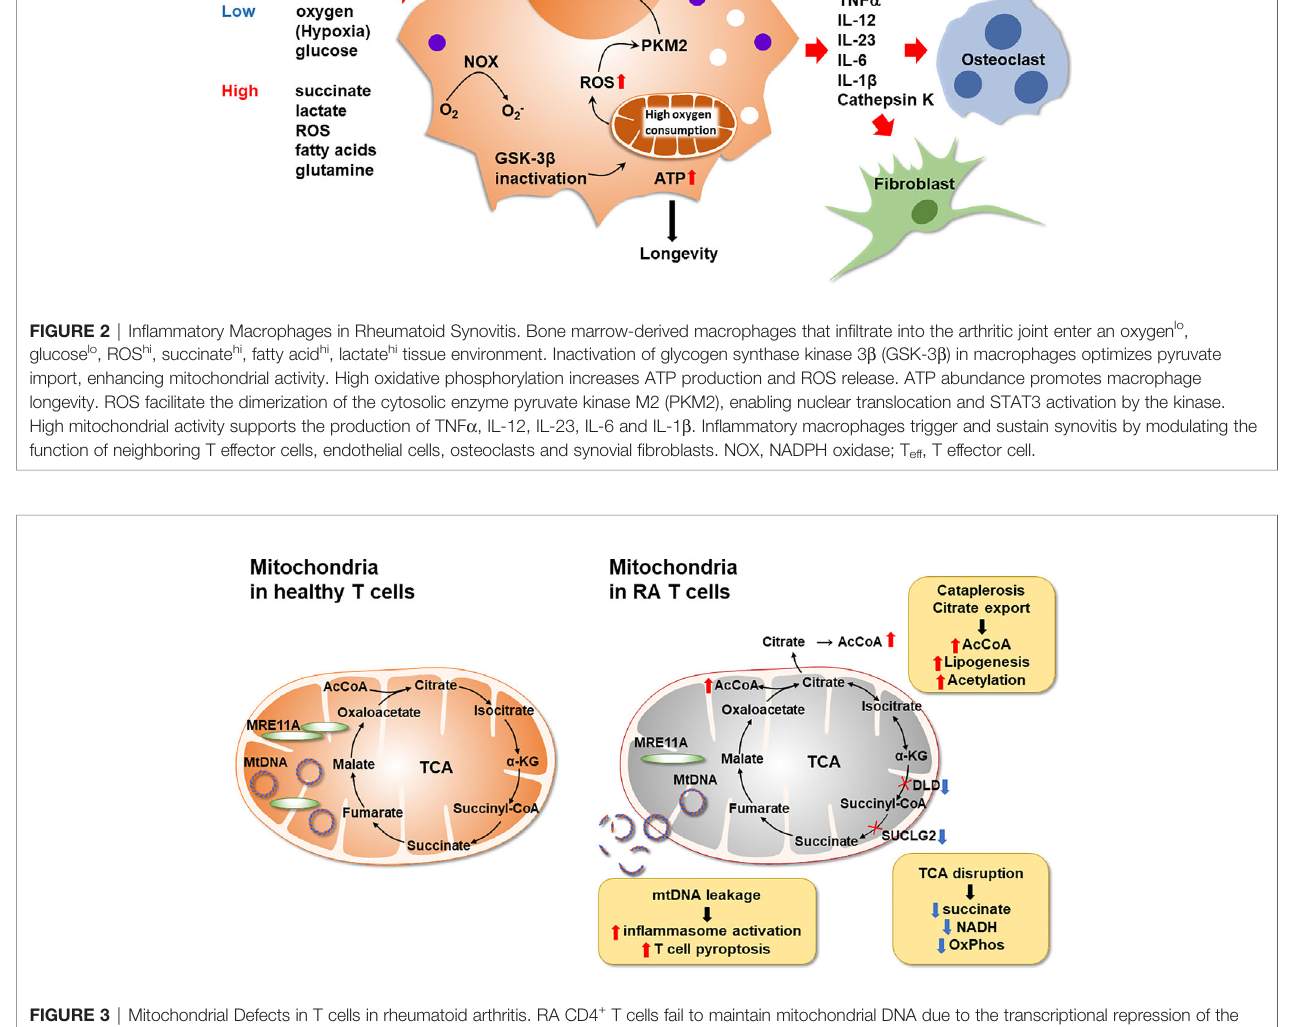
FIGURE 3 | Mitochondrial Defects in T cells in rheumatoid arthritis. RA CD4 + T cells fail to maintain mitochondrial DNA due to the transcriptional repression of the nuclease MRE11A, a limiting factor in DNA double-strand break repair and replication fork protection. Instability of mtDNA causes leakage of mtDNA fragments into the cytosol, triggering activation of the in fl ammasome and eventually T cell pyroptotic death. Mitochondrial oxidative phosphorylation is further impaired by the disruption of the TCA cycle. Transcriptional repression of succinyl-CoA ligase (SUCLG2) prevents the conversion of a-ketoglutarate into succinate and forces the TCA cycle to change direction. In a cataploretic reaction, mitochondria of RA T cells produce and export excess citrate, creating an acetyl-CoA-rich environment in the cytoplasm. Together with NADPH generated in the hyperactive pentose phosphate pathway surplus acetyl-CoA enters biosynthesis, speci fi cally lipogenesis. Also, excess acetyl-CoA drives protein acetylation, including the acetylation of microtubules. a -KG, a -ketoglutarate; mtDNA, mitochondrial DNA; SUCLG2, Succinate-CoA Ligase GDP-Forming Subunit